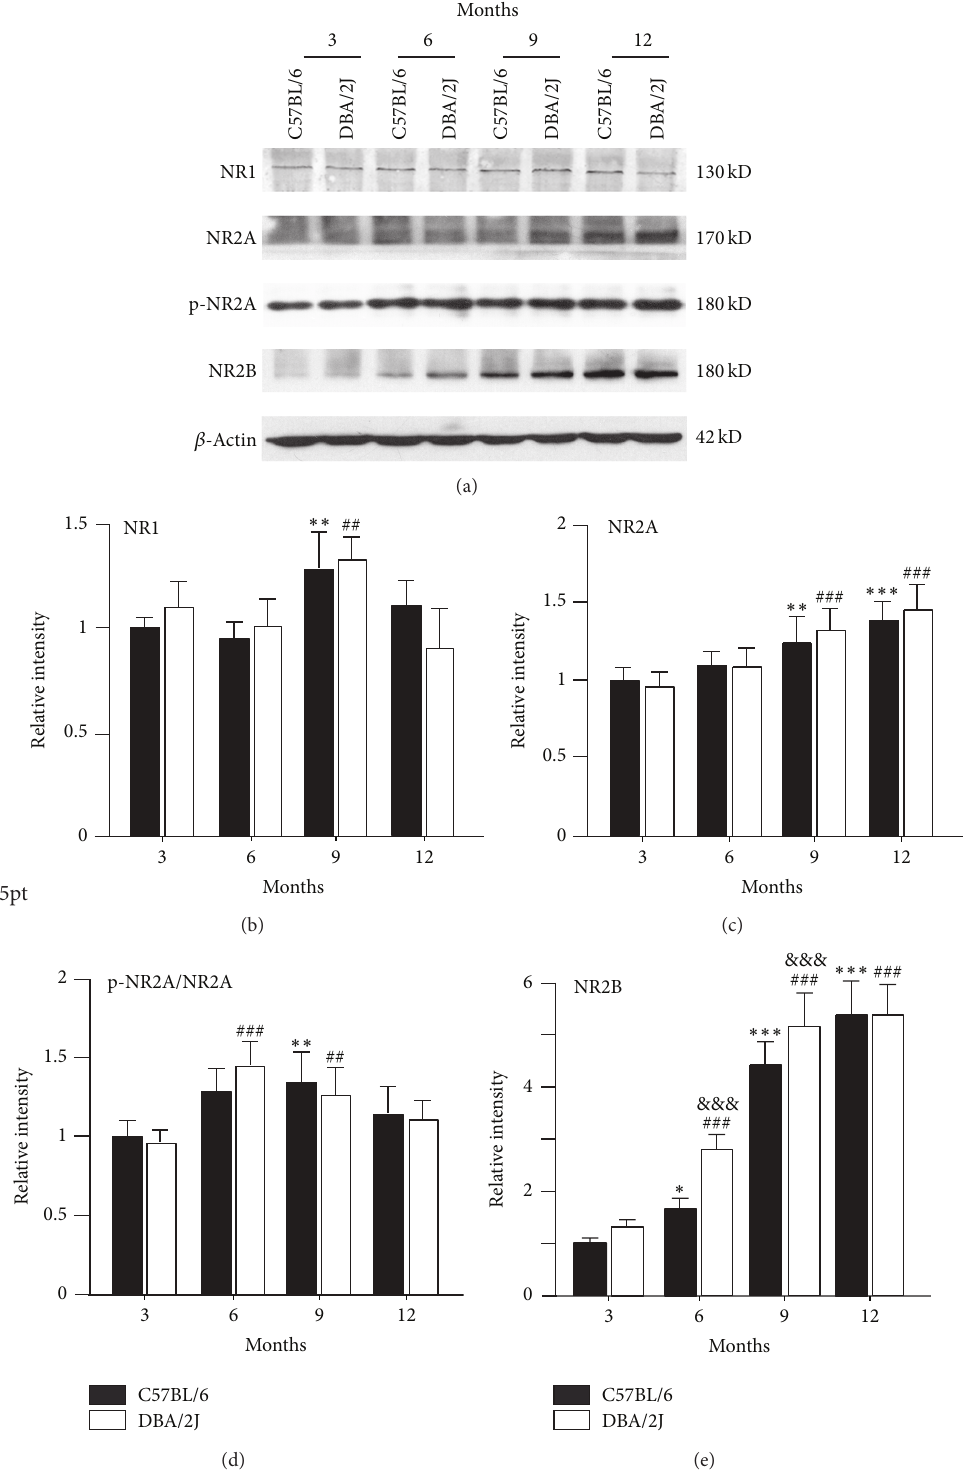
Figure 2: Changes in expression of NMDA receptor subunits of DBA/2J mice at various ages. (a) Representative immunoblots showing the changes of NR1, NR2A, p-NR2A S1232 , NR2B levels in DBA/2J and C57BL/6 mice at ages of 3, 6, 9, and 12 months. (b)–(e) Bar chart showing the average densitometric quantification of immunoreactive bands of NR1 (b), NR2A (c), p-NR2A S1232 /NR2A (d), and NR2B (e) in DBA/2J and C57BL/6 mice at ages of 3, 6, 9, and 12 months, respectively. ∗ 𝑃 < 0.05 , ∗∗ 𝑃 < 0.01 and ∗∗∗ 𝑃 < 0.001 versus 3-month-old C57BL/6 mice; ## 𝑃 < 0.01 and ### 𝑃 < 0.001 versus 3-month-old DBA/2J; &&& 𝑃 < 0.001 versus age-matched C57BL/6